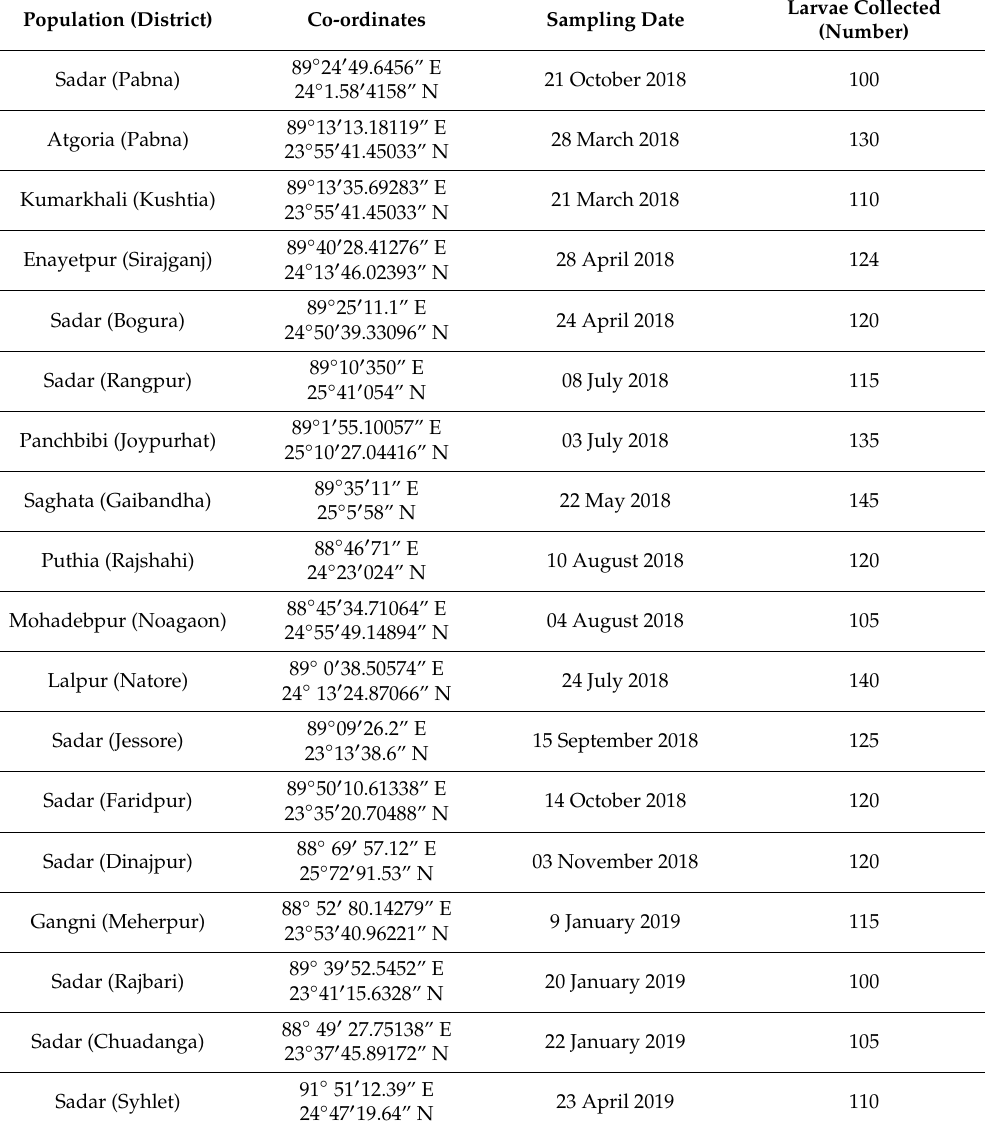
Table 1. Details of Leucinodes orbonalis populations collected from di ff erent brinjal growing districts of Bangladesh in